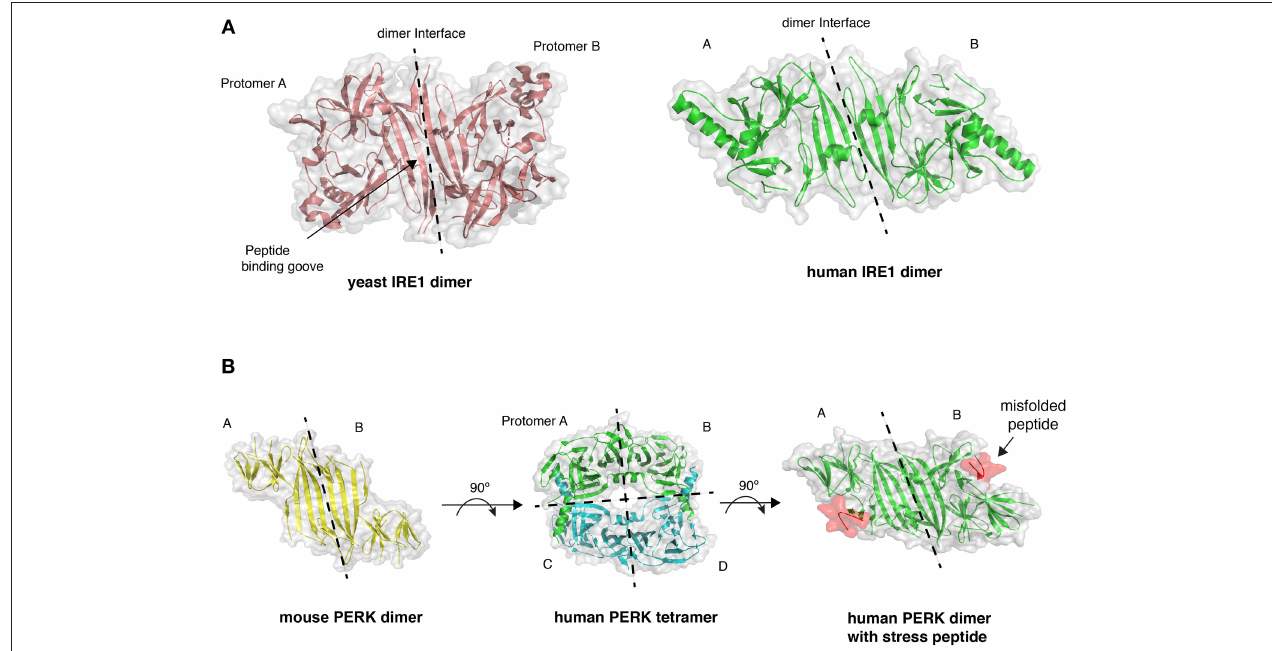
FIGURE 2 | Crystal structures of LD. (A) The dimer arrangement of IRE1 LD from both yeast (PDB 2BE1) and human (PDB 2HZ6) proteins, with dimer interface marked by dashed line. (B) PERK LD dimer structure shares similar architecture to IRE1 LD. PERK LD has also been visualized in a tetramer arrangement comprising two sets of dimers (PDB 4YZS and 4YZY), and PERK LD bound to peptide (PDB